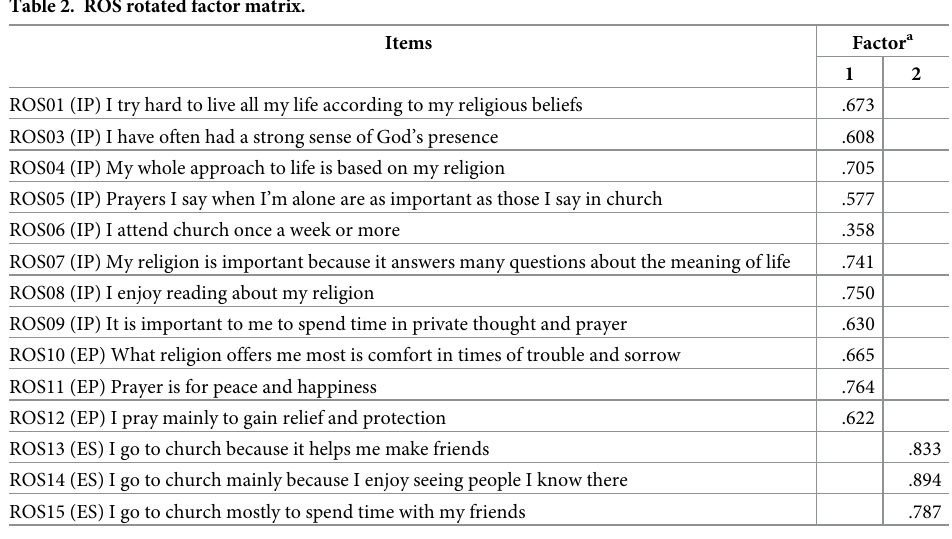
Table 2. ROS rotated factor